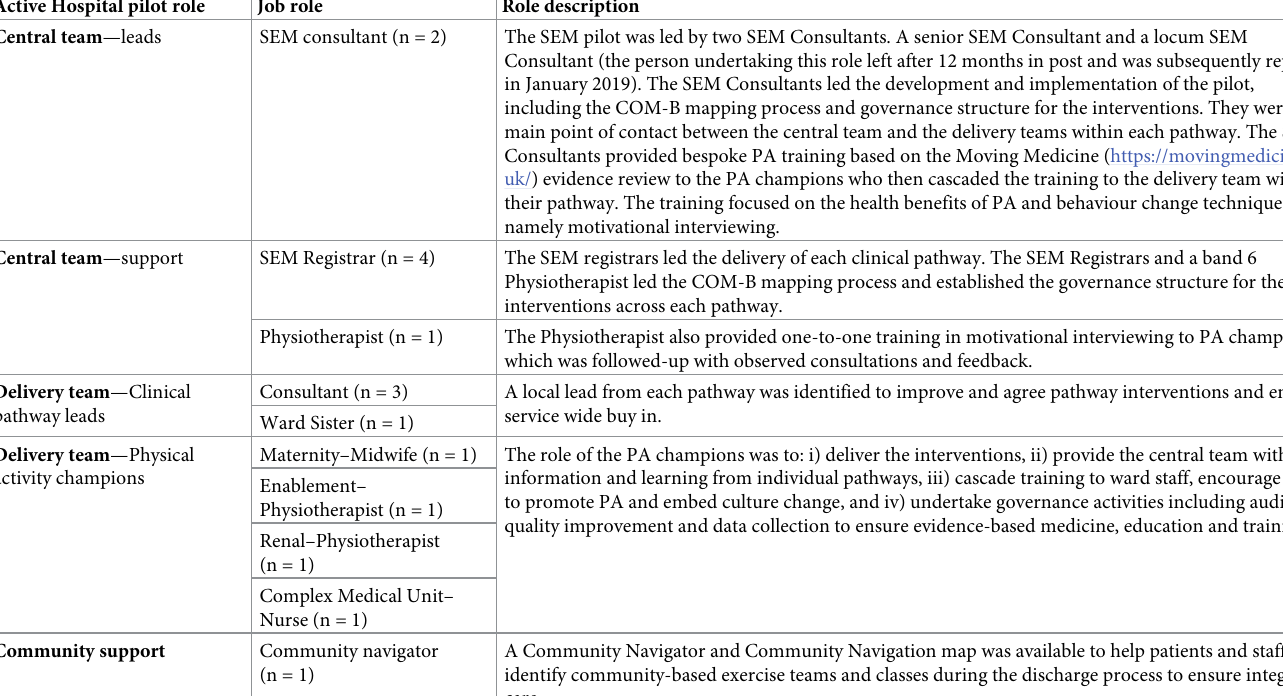
Table 2. The OUHFT Active Hospital pilot delivery team